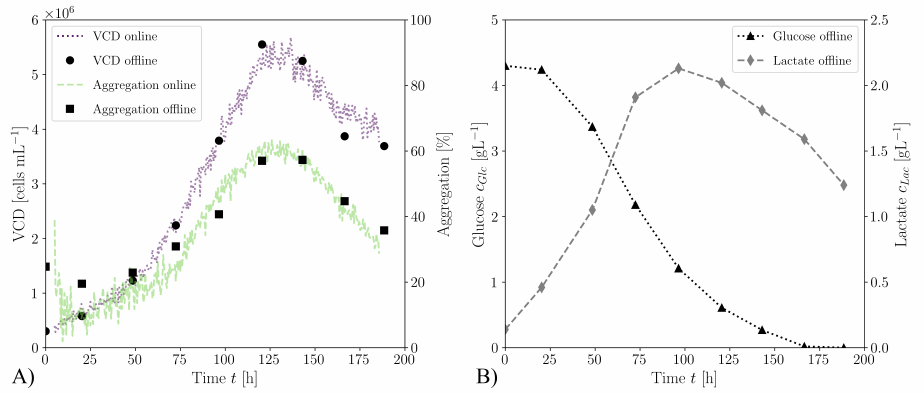
Figure 12. ( A ) Temporal development of VCD and aggregation during cultivation with a stirrer speed of 180rpm. The values measured online with the Ovizio iLine F analyser match the values measured offline over the entire cultivation period. ( B ) Temporal development of the offline measured glucose c Glc and lactate c Lac concentration for the same cultivation.